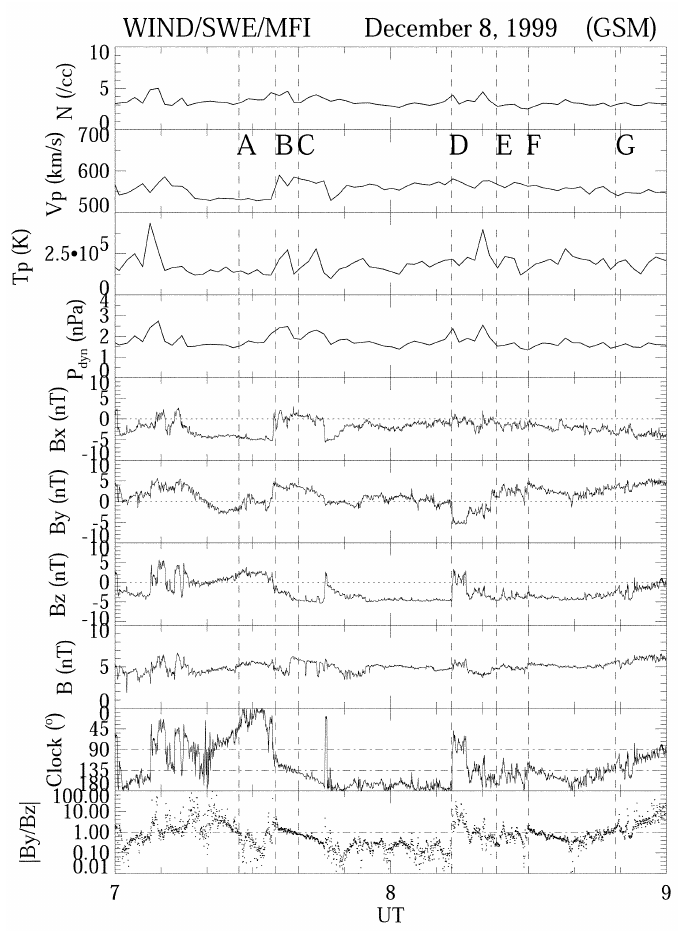
Fig. 1. Solar wind plasma and IMF data obtained from Wind during the interval 07:00–09:00 UT on 8 December 1999. Panels from top to bottom show: proton density, bulk velocity, proton temperature, solar wind dynamic pressure, interplanetary magnetic field (IMF) components B x , B y , B z , the field magnitude, the IMF clock angle, and the ratio | B y /B z | . Field orientation regimes are marked by vertical guidelines